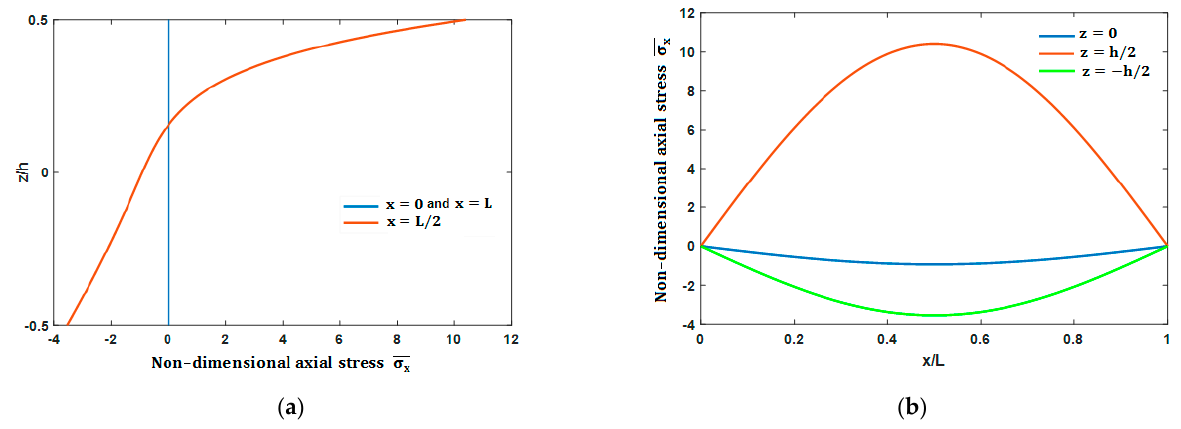
Figure 9. 𝜎 (cid:3051) distributions: ( a ) over the FG beam thickness, ( b ) versus the FG beam non-dimensional length. Figure 10a,b plots the distributions of the non-dimensional shear stress 𝜎 (cid:3051)(cid:3053) through thethickness and versus the non-dimensional length of the FG beam, respectively, for ( L / h = 5) and ( p = 5). These figures reveal that the shear stress reaches its maximum value at the beam ends but with opposite signs. It is cancelled in the middle of the beam on the neutral plane and the lower and upper faces. As a result, the conditions of non-shearing on both the lower and upper faces of the beam are satisfied.